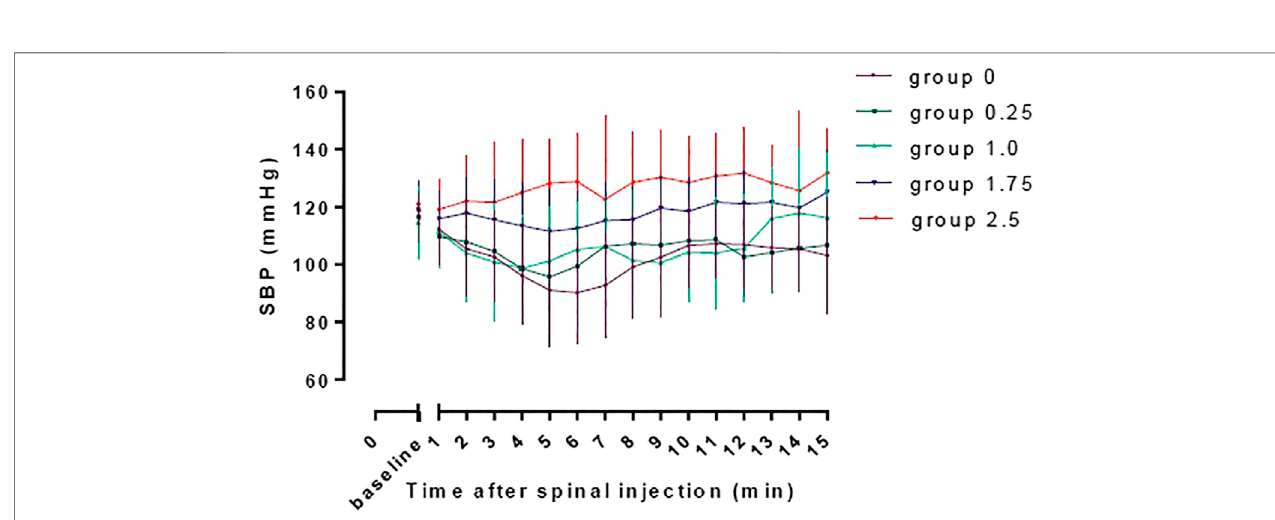
FIGURE3| ThebaselineSBPandSBPinthe fi rst15 minafterspinalinductioninthe fi vegroups.Theareaunderthecurvewere2002 ± 51,2065 ± 41,2,109 ± 57, 2,355 ± 39, and 2,356 ± 53 min mm Hg in group 0, 0.25, 1.0, 1.75, and 2.5, respectively, and there was a signi fi cant linear trend across groups ( p < 0.001). Signi fi cant difference was found in AUC between group 2.5 and group 0, 0.25 and 1.0 (adjusted p < 0.001) and between group 1.75 and group 0 and 0.25 (adjusted p < 0.001).